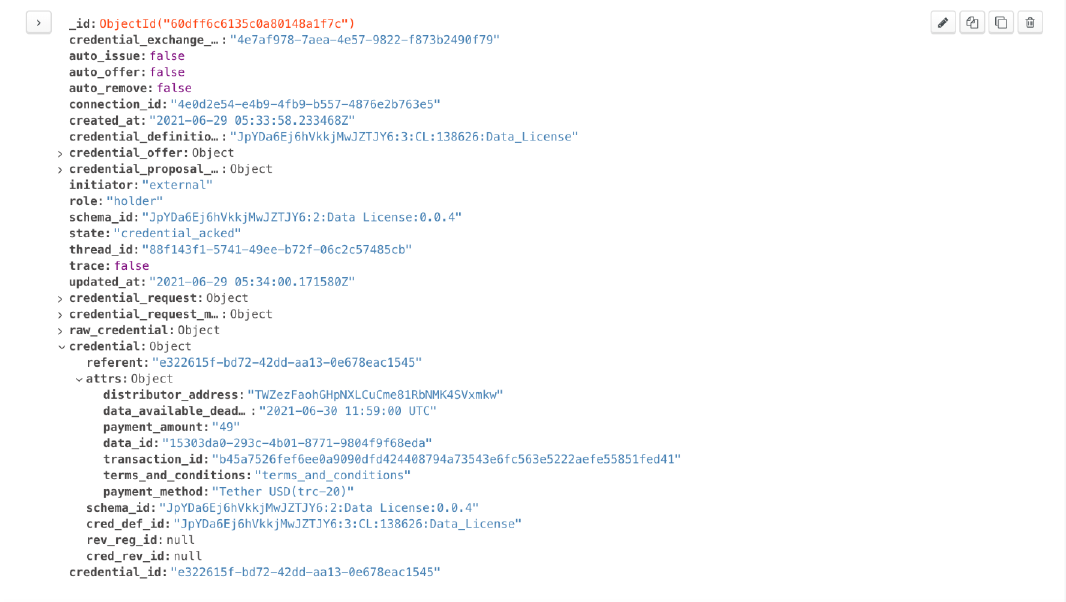
Fig. 11. The license credential.